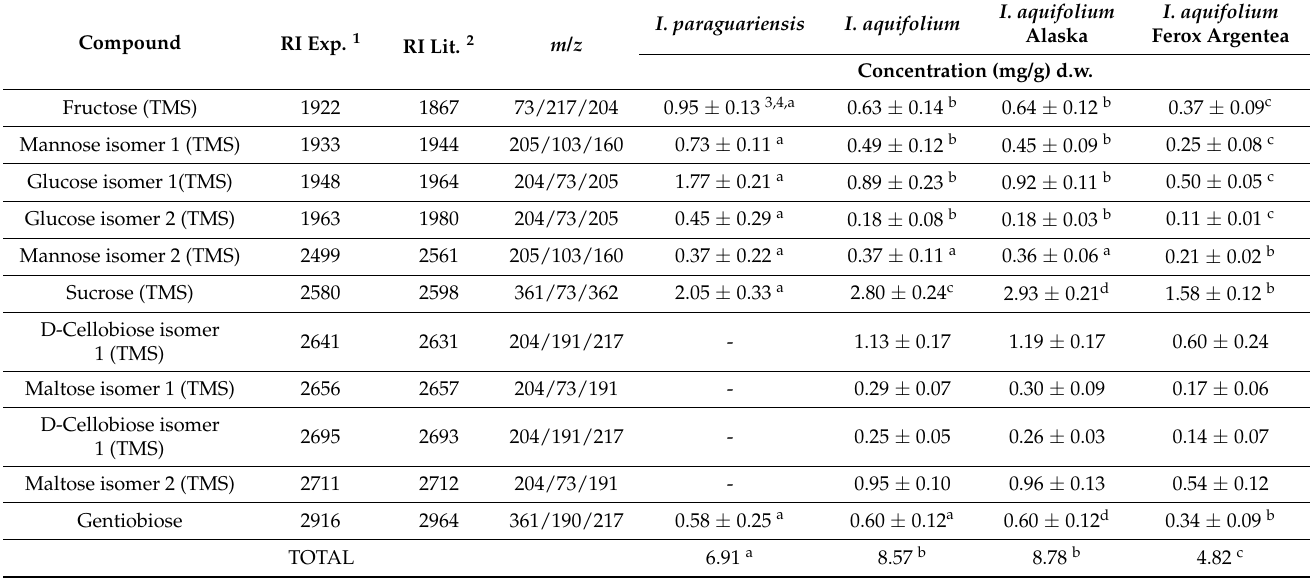
Table 5. Sugar profile of I. paraquariensis and various varieties of I. aquifolium